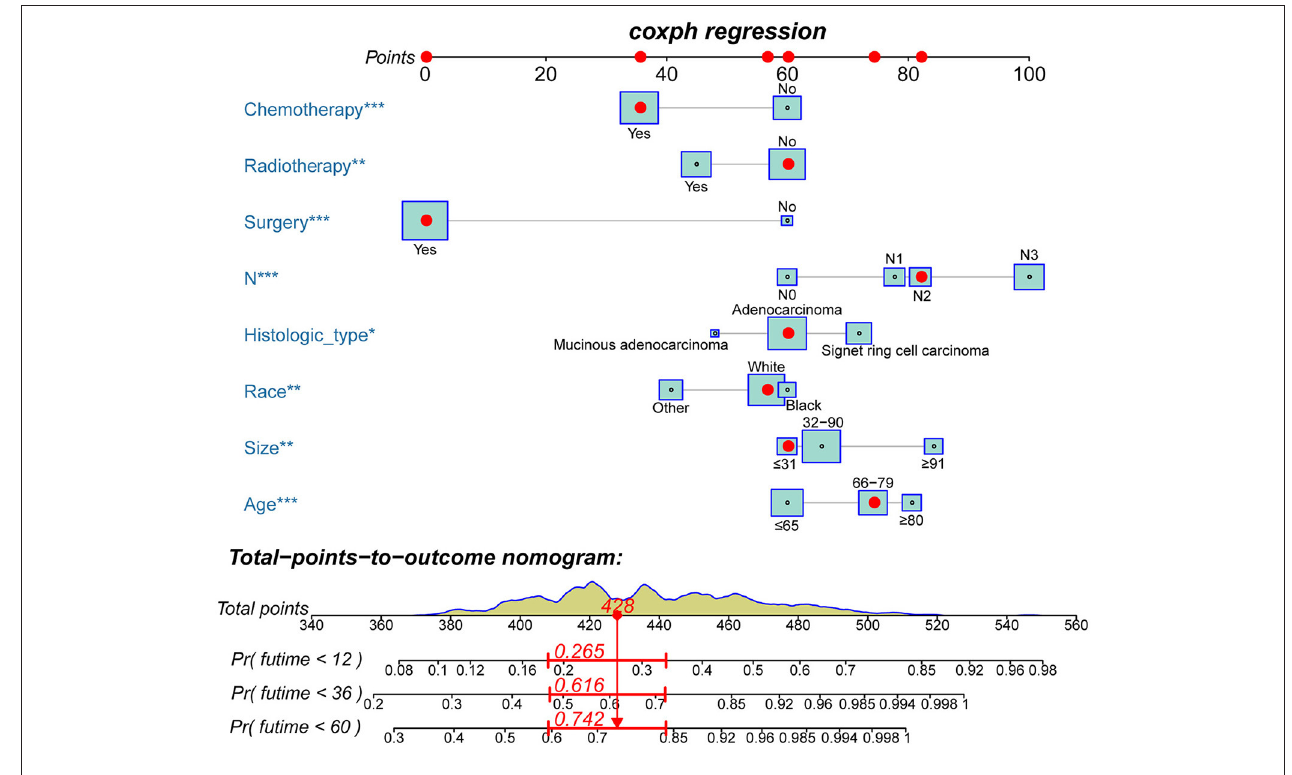
FIGURE 1 | The novel nomogram to predict 1-, 3-, and 5-year OS of patients with T4a GC.